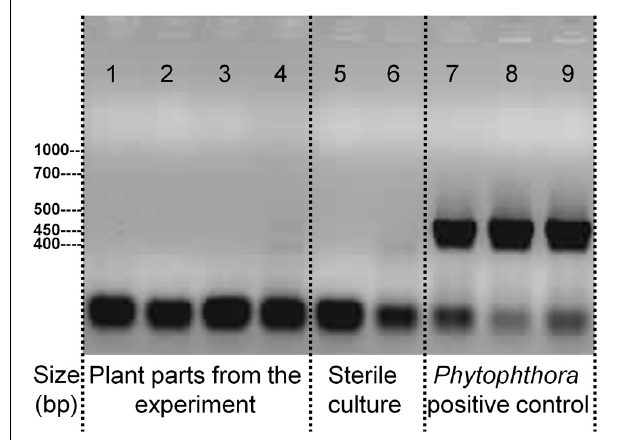
FIGURE 5 | PCR-test for the presence of DNA specific to the parasitic Oomycet genus Phytophthora in the experiment. Applied PCR-primers are specific to the entire genus. Displayed samples are from the experiment itself with 1. A. thaliana roots, grown in presence of H. pilosella , 2. A. thaliana leaf, grown in presence of H. pilosella , 3. H. pilosella roots, 4. A. thaliana roots, grown in absence of H. pilosella ; or are samples